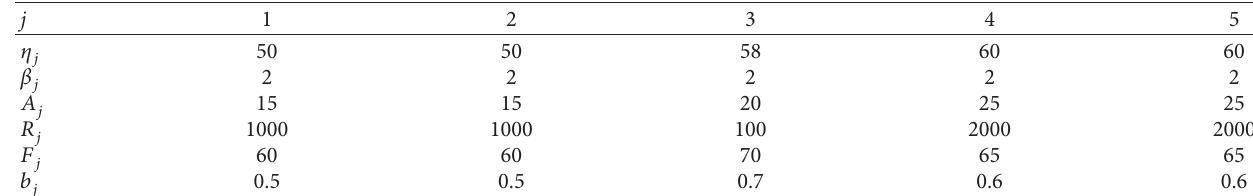
Table 3: The related maintenance parameters.